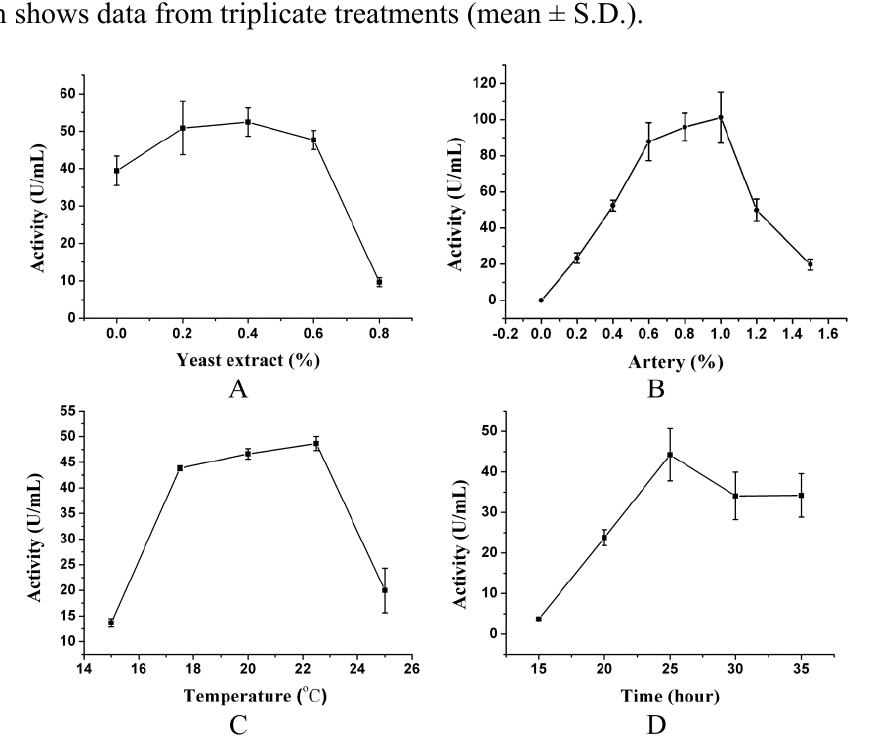
Figure 1. Effects of four factors on the pseudoalterin production of CF6-2. The four tested factors are yeast extract content ( A ) and artery powder content ( B ) in the medium, culture temperature ( C ) and culture time ( D ). CF6-2 was cultured under the fermentation conditions described in Experimental Section with a tested single factor being